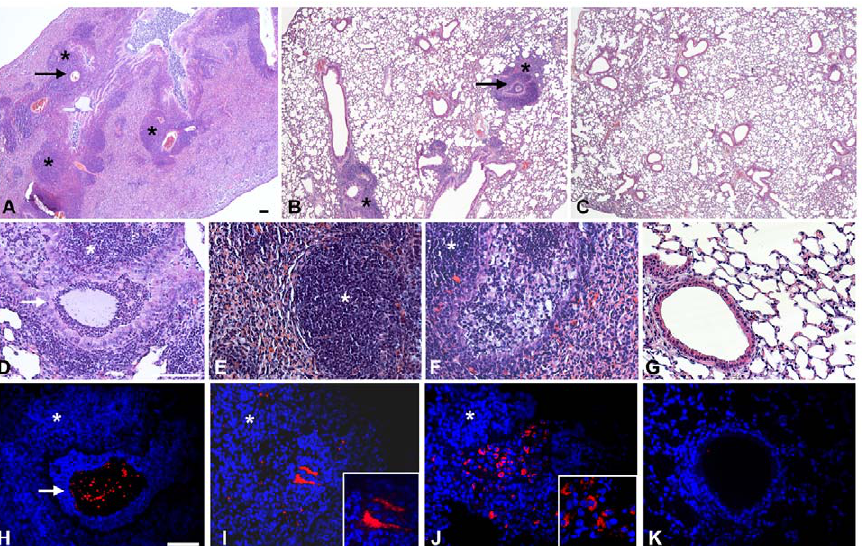
Figure 3. Murine lung histology and localization of P.aeruginosa Pos-STM mutants after 14 days. Mice were infected with 2 6 10 6 cfu/lung of P. aeruginosa Pos-STM strains embedded in agar beads. In this panel, PA5053- hslV ( A and B ), PA2998- nqrB ( D and H ), PA4554- pilY1 ( E and I ) and PA0499 ( F and J ) are taken as representative of the whole set of 16 Pos-STM mutants. Control mice were infected with PAO1293 wt ( C, G and K ). The lungs were stained with H&E ( A–G ) or with specific antibody against P. aeruginosa strains (red) ( H–K ). Counterstaining was performed with 4 9 ,6- Diamidino-2-phenylindole dihydrochloride (DAPI) (blue) ( H–K ). Bronchi and pulmonary parenchyma are characterized by chronic lesion (*) infiltrated by macrophages, lymphocytes and neutrophils. Severity of lesions and lung involvement is heterogeneous in different lobes of the same mice ( A and B ). Bronchi contain massive granulocyte infiltration of bacteria and agar beads (arrow) ( D and H ) or bronchial wall is disrupted and the bronchial lumen is filled by foamy macrophages and bacteria presumably internalized by inflammatory cells ( F and J ). Bacterial macrocolonies are visible in the pulmonary parenchyma outside the beads ( E and I ). PAO1293 wt infected mice resolved the infection and inflammation ( C, G and K ). A–C: 2.5 6 ; D–K: 20 6 ; insert I–J: 63 6 . Confocal microscopy ( H–K ). Bars, 100 m